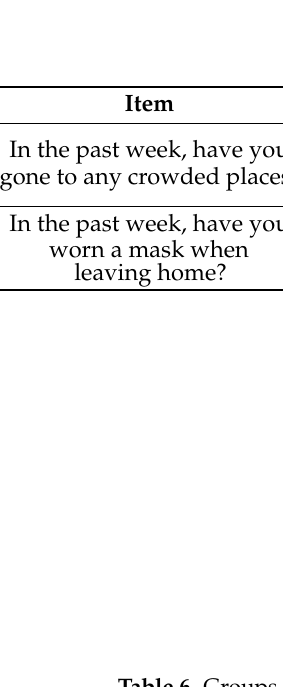
Table 6. Groups of information sources and wearing masks while being outdoors, May 2020 ( n = 951).